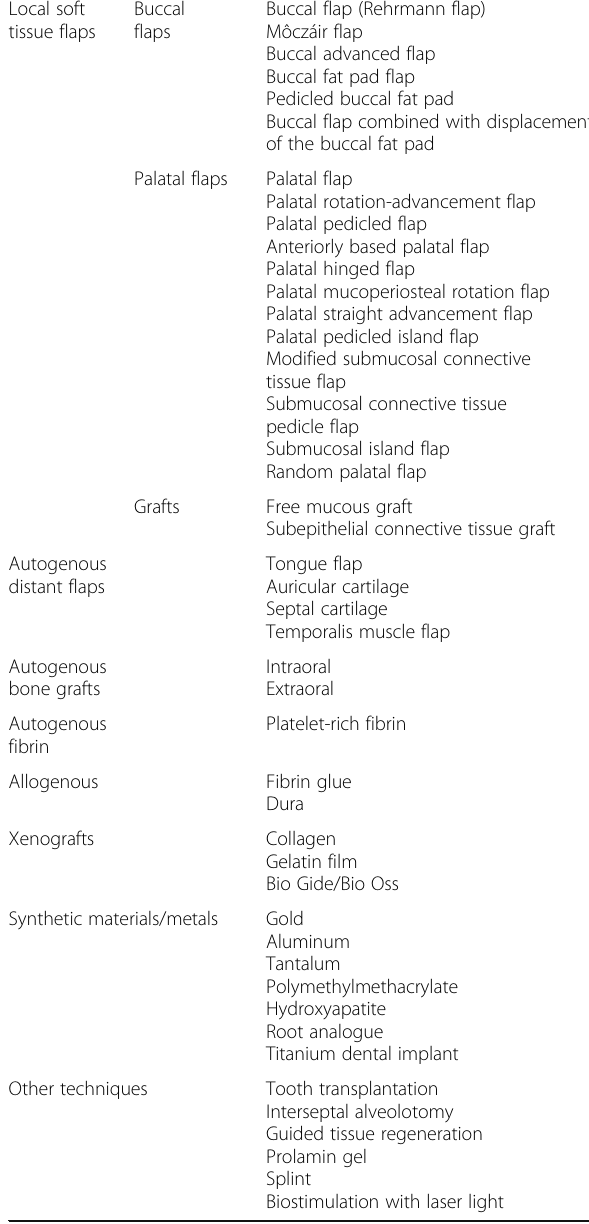
Table 1 Techniques for closure OAC/OAF Local soft tissue